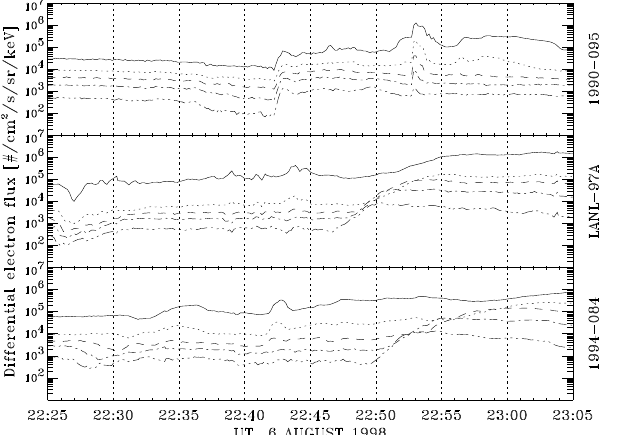
Fig. 2. Differential electron flux from three LANL satellites in geosynchronous orbit. Solid line: 50–75keV. Dotted line: 75–105keV. Dashed line: 105–150keV. Dash-dotted line: 150– 225keV. Dash-dot-dot-dot line: 225–315keV. Upper panel: Data from satellite 1990-095. At 22:42 UT the satellite is at 19:50 MLT. Middle panel: Data from satellite LANL-97A. At 22:47 UT the satellite is at 03:01 MLT. Lower panel: Data from satellite 1994- 084. At 22:49UT the satellite is at 05:21 MLT.